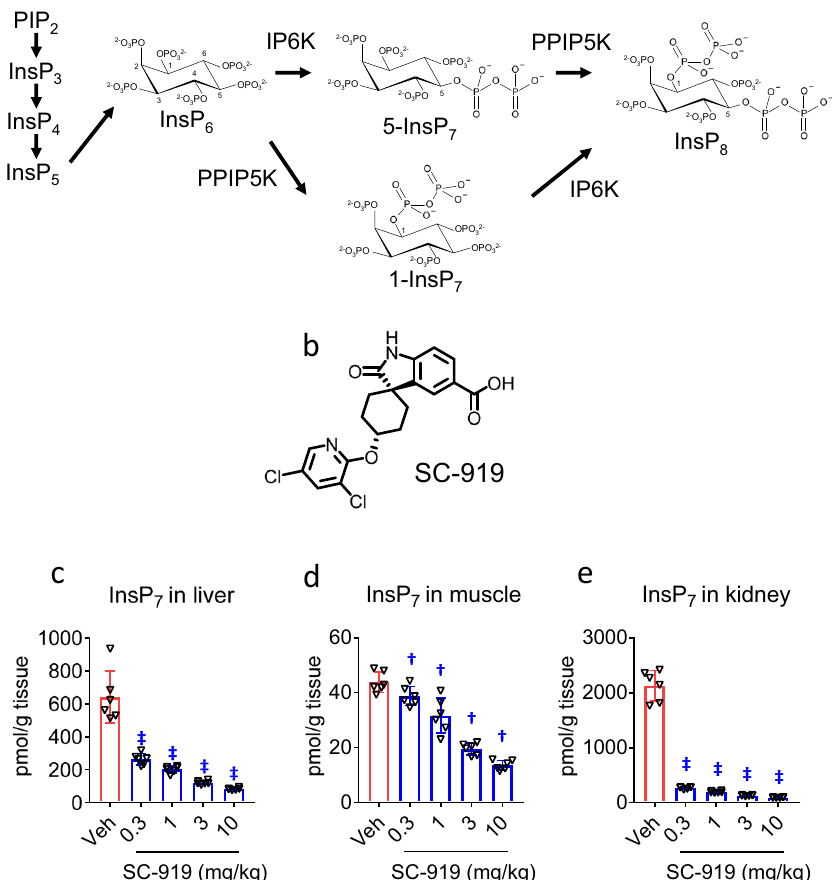
Fig. 1 SC-919 is an effective inhibitor of IP6K in vivo. a IP6K-mediated synthesis of the inositol pyrophosphates. PIP 2 phosphatidylinositol 4,5-bisphosphate, Ins inositol; the subscripts denote the total number of phosphates; PPIP5K diphosphoinositol pentakisphosphate kinase. b The chemical structure of SC-919. InsP 7 levels in the liver ( c ), muscle ( d ), and kidney ( e ) after 2h of SC-919 administration to rats. Values indicate mean±S.D. ( n = 6 biological replicates). † P <0.05 and ‡ P <0.05 vs. vehicle as determined using Williams ’ test and Shirley – Williams test, respectively. Veh